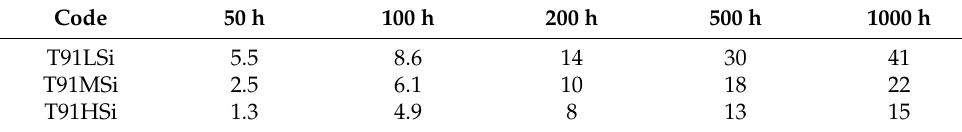
Table 5. Average oxide film thickness ( µ m) at different corrosion times static LBE. Code